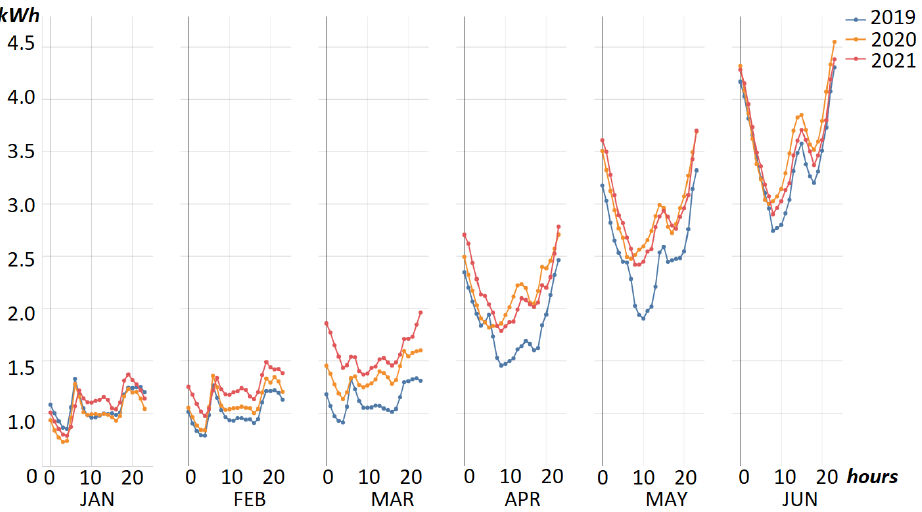
Figure 9. Mean hourly consumption profiles for AC-included category consumers for the first 6 months over 3